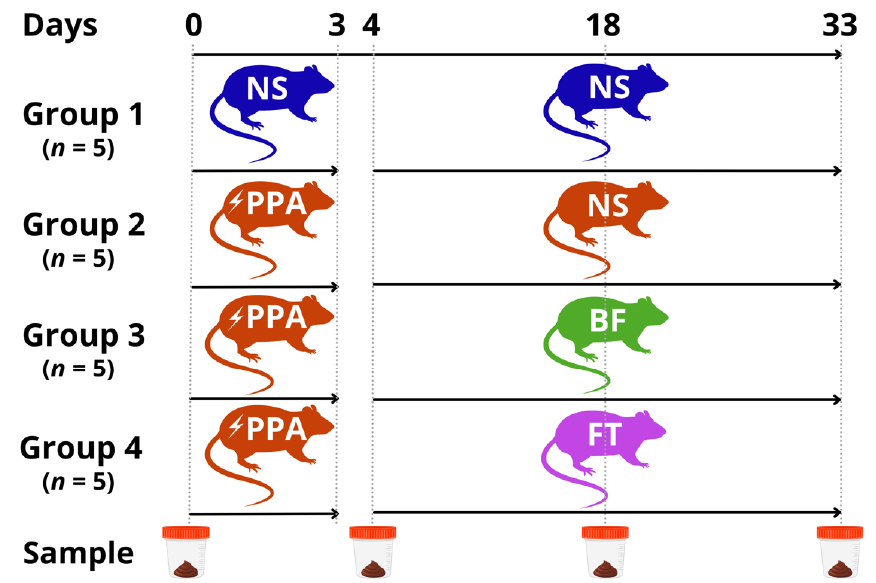
Figure 1. Schematic representation of the experimental design. Normal Saline (NS); propionic acid (PPA); Bifidobacterium longum (BF); or fecal microbiota transplantation (FT).